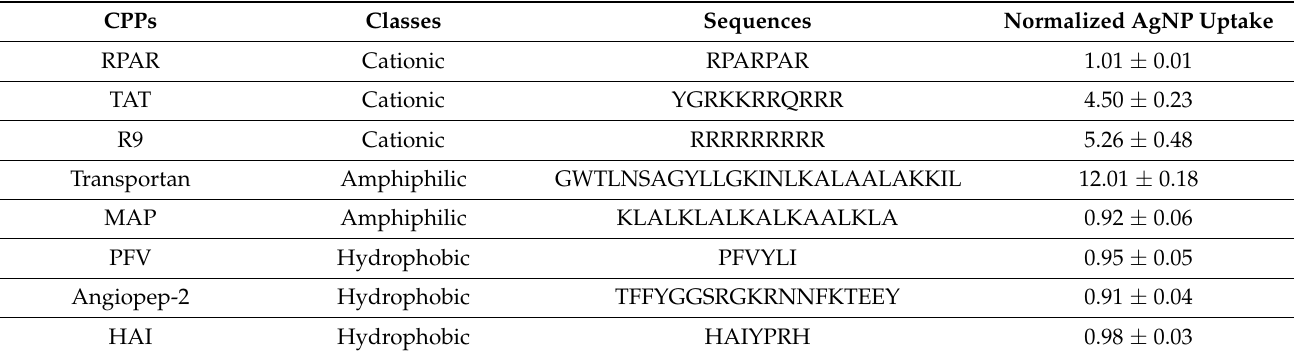
Table 1. Example CPPs and their bystander